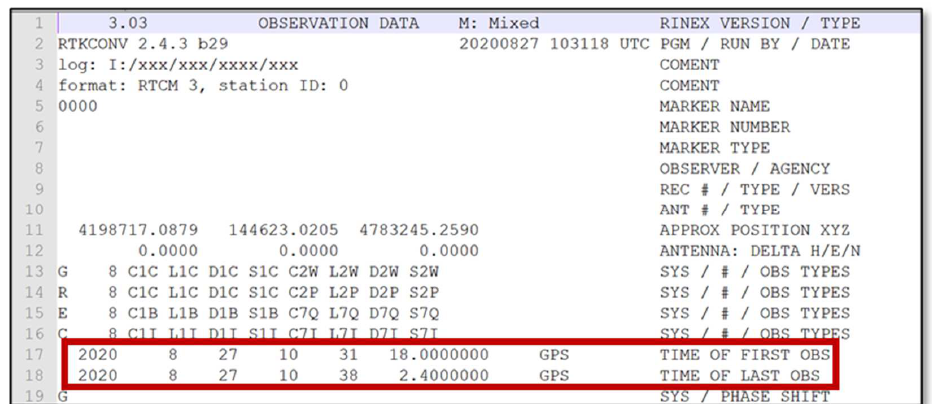
Figure 15. Rinex observations file “100_0340_Rinex.obs” recorded during the GNSS mode flight of 27 August 2020 on the study area. Time of first and last observations.